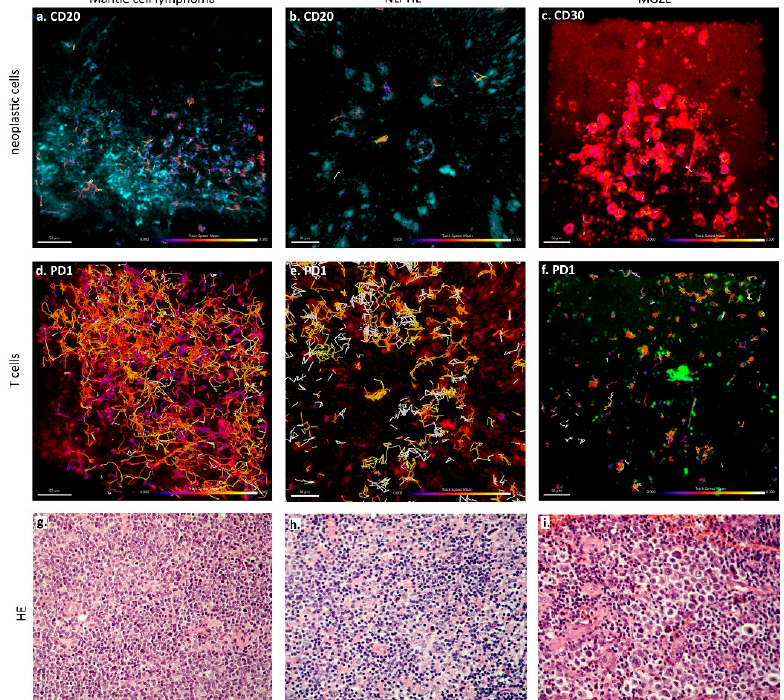
Figure 2. Cell tracks according to different lymphoma types superimposed on fluorescence images. ( a – c ) Tracks of the tumor cells of mantle cell lymphoma ( a ), NLPHL ( b ) and MGZL ( c ) in CD20- or CD30-immunostaining, as indicated. Color of tracks corresponds to the observed velocity as indicated in the scale . ( d – f ) Tracks of the bystander T cells of the same cases: mantle cell lymphoma ( d ), NLPHL ( e ) and MGZL ( f ) in PD1-staining. Color of tracks corresponds to the observed velocity as indicated in the scale. ( g ) HE staining (200x) of the mantle cell lymphoma from ( a , d ). ( h ) HE staining (200x) of the NLPHL from ( b , e ). ( i ) HE staining (200×) of the MGZL from ( c , f ). 3.5. CD30-Positive Normal Cells Move Faster than CD30-Positive Lymphoma Cells CD30 immunostaining was performed in several cases of lymphadenitis as well as CD30-positive and -negative lymphomas. CD30 is expressed in the tumor cells of some lymphomas like cHL, MGZL and EBV-associated DLBCL. However, CD30-positive cells are also found under almost all reactive conditions and also occur as CD30-positive by- stander cells, usually activated T cells, in CD30-negative lymphomas. We thus analyzed velocity separately in the different lymphoma types depending on CD30-positivity of the tumor cells, which was the case for all cHL and MGZL and one case of EBV-associated DLBCL. CD30-positive tumor cells showed a mean velocity of 3.29 µm/min. CD30-posi- tive bystander cells were slightly faster, with a mean velocity of 5.00 µm/min observed in CD30-negative lymphomas and lymphadenitis ( p = 0.01, Mann–Whitney test; Figure 1f). Interestingly, the CD30-positive tumor cells of the EBV-associated DLBCL were signifi- cantly faster (5.58 µm/min) than the CD30-positive tumor cells in MGZL (2.69 µm/min, p < 0.05, Kruskal–Wallis test with Dunn’s post-test for multiple comparisons; Supplemen- tary Figure S1). The Hodgkin and Reed–Sternberg cells in cHL showed a comparable ve- locity (mean 3.31 µm/min) to MGZL, but this was not significantly different from DLBCL.